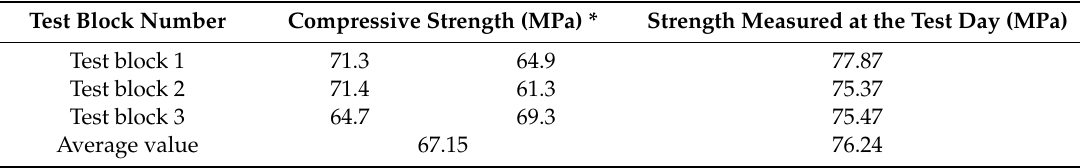
Table A6. Concrete strength obtained from experimental test on C60 HPC cubic specimen at the same condition with bridge deck.